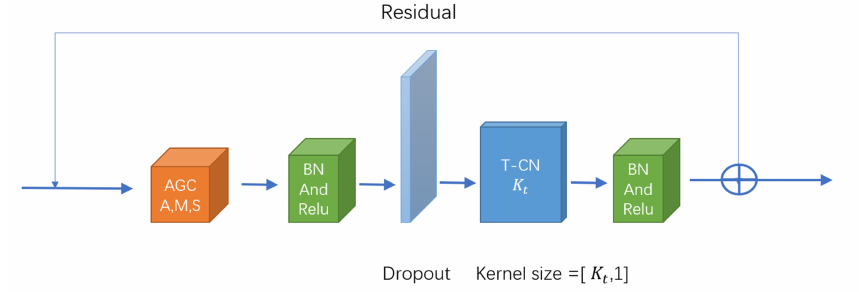
Figure 3. An AGCN block consists of spatial GCN(AGC), temporal GCN(T-CN), and other operations: batch normalization (BN), Relu, dropout, and the residual block. A, M, and S in AGC represent the adjacency matrix, edge importance matrix, and similarity matrix,